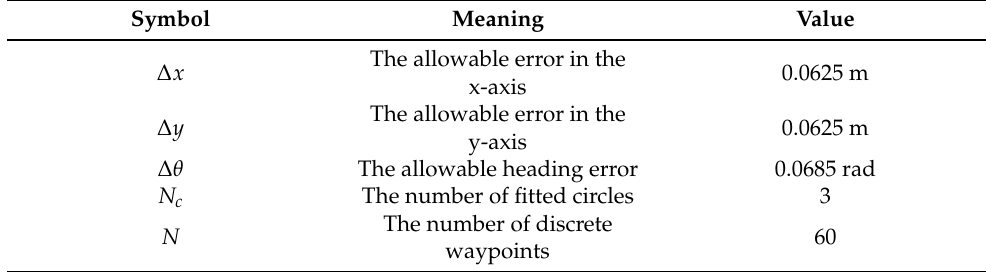
Table 2. The proposed method